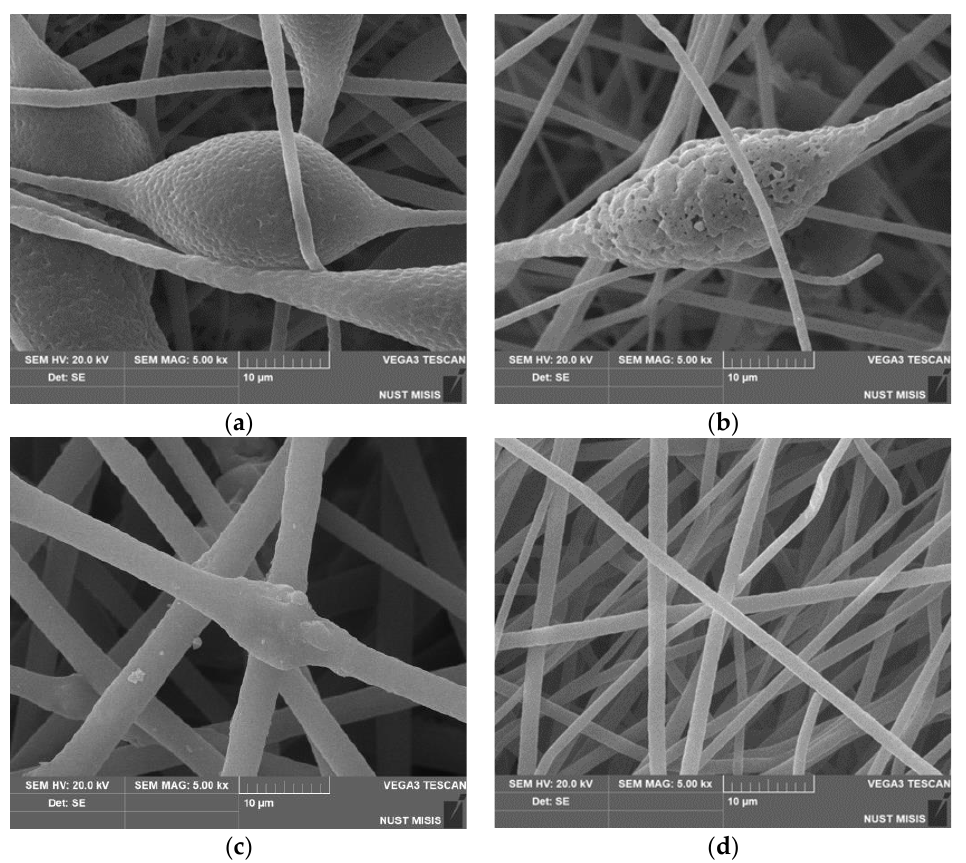
Figure 2. Micrographs of PHB with different hemin content: ( a ) 0%, ( b ) 1%, ( c ) 3% and ( d )